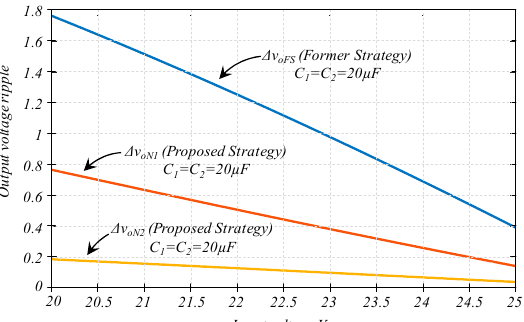
Figure 8. Output voltage ripple calculation for the full operation range with C1 = C2 = 20 µF.